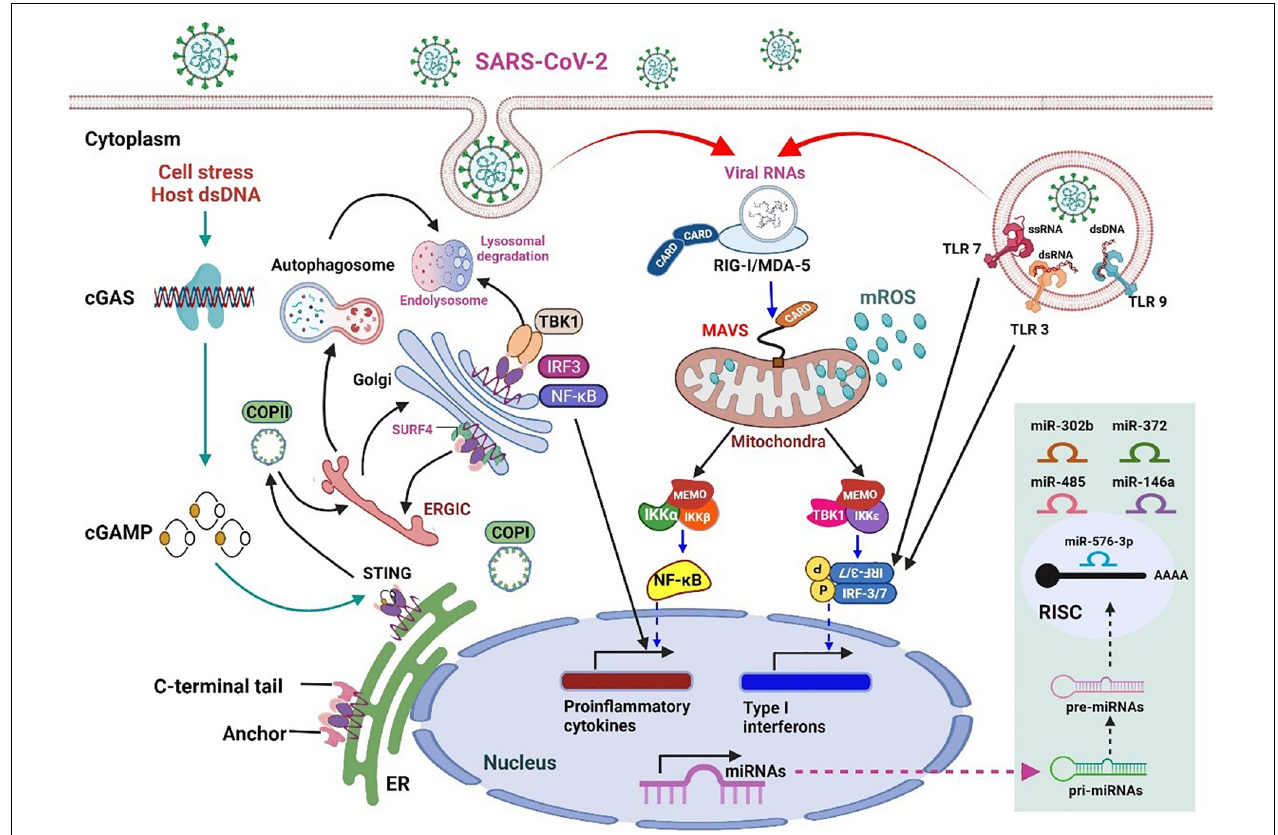
FIGURE 2 | An overview of innate immunity against RNA virus infection and the stress response to host cell infection in